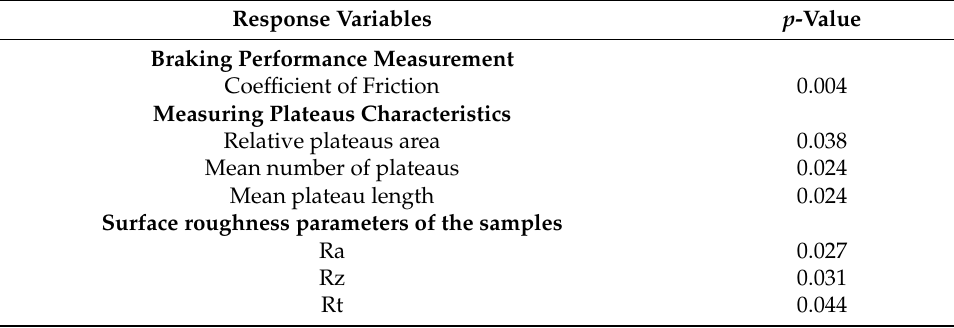
Table 3. Summary of the t -test